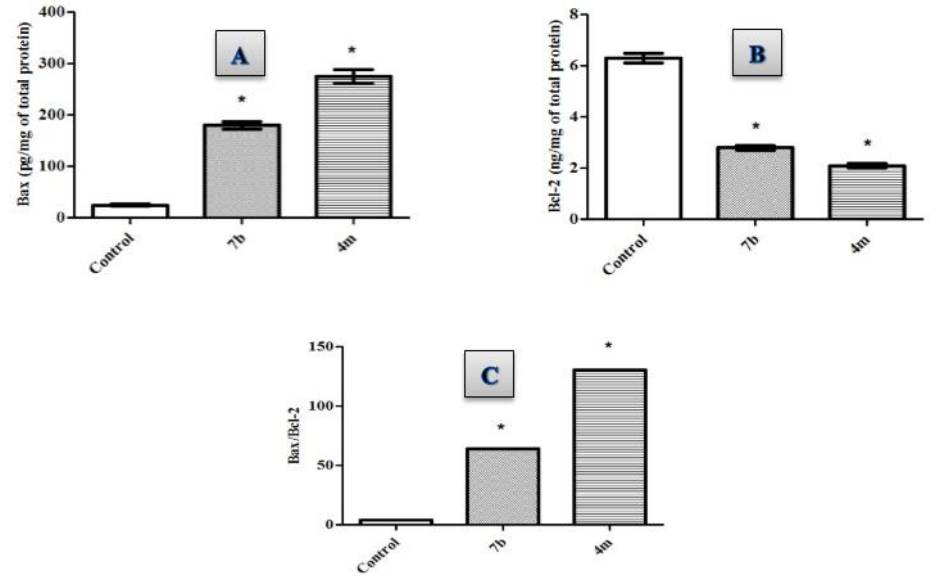
Figure 2. Effect of compounds 4m and 7b on the protein levels of ( A ) Bax; ( B ) Bcl-2; ( C ) Bax/Bcl2 ratio in MDA-MB-231 cells treated with the compounds at their IC 50 concentrations against control (1% DMSO). Data are mean ± S.D. ( n = 3). The experiment was done in triplicates. * Significantly different from control at p < 0.05.